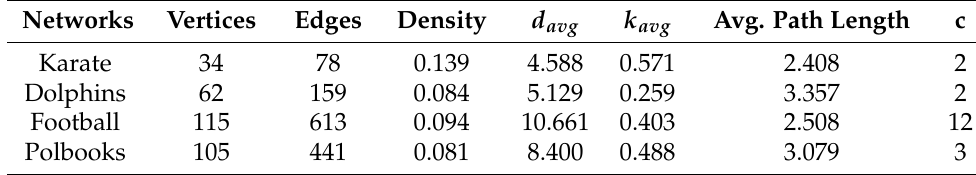
Table 1. Attributes of four real-world networks.